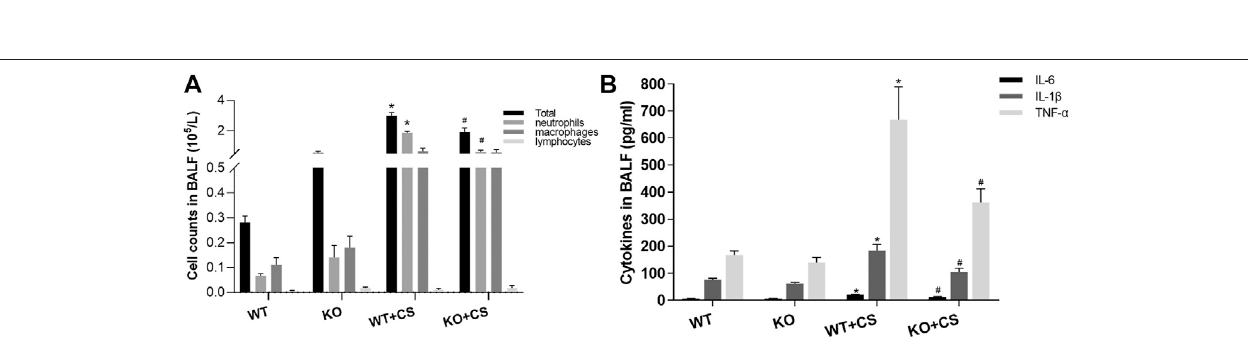
FIGURE 2 | FPR-1 KO diminishes cell counts and pro-in fl ammatory cytokines in BALF after CS exposure. (A) Total cells, neutrophils, macrophages, and lymphocytes in the BALF and (B) IL-1 β , IL-6, and TNF- α concentrations in the BALF. * p < 0.05 vs. WT group, # p < 0.05 vs. WT + CS group. n (cid:1) 6 in each group. Abbreviations: CS, cigarette smoke; WT, wild type; KO, knockout; BALF, bronchoalveolar lavage fl uid.